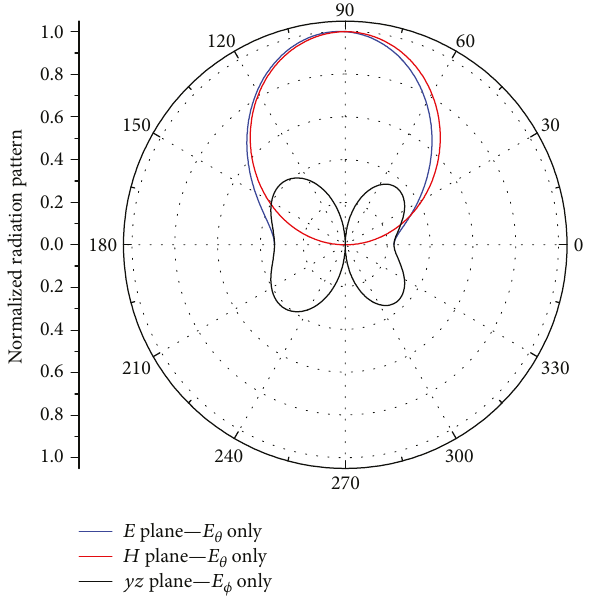
Figure 11: Normalized radiation pattern of the HB antenna.